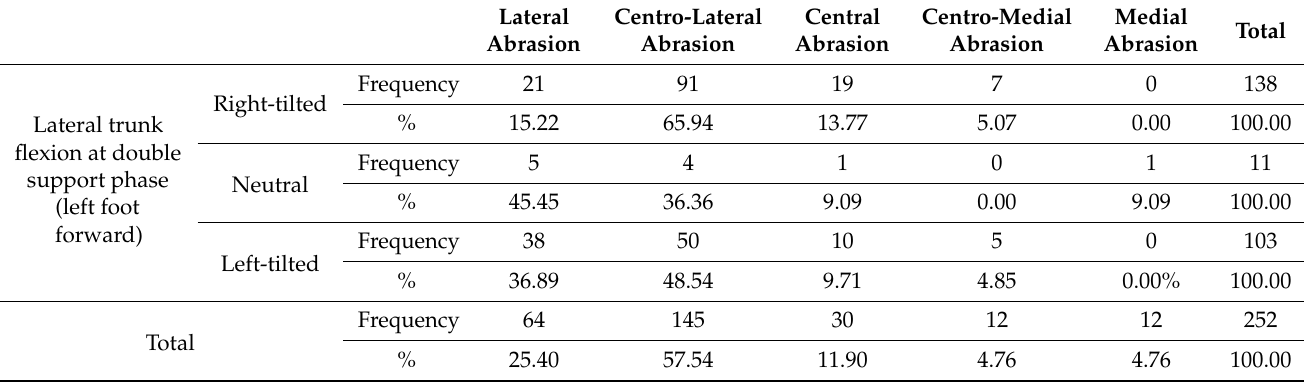
Table 9. Relationship between the lateral trunk flexion at the double support phase (left foot forward) and left shoe abrasion classification (X 2 = 40.09, df = 8, p = 0.00).